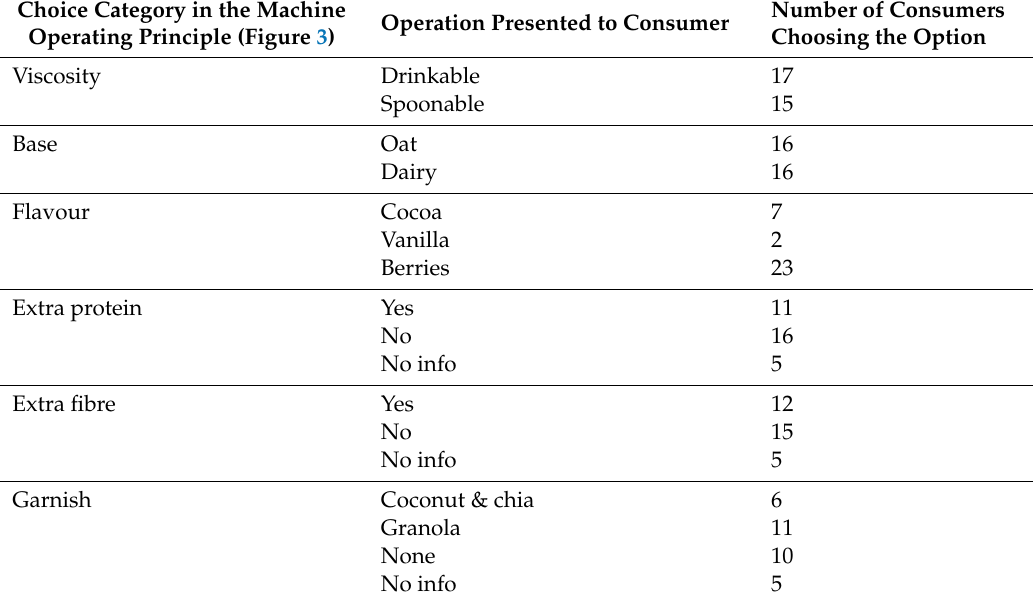
Table 4. Consumer choices ( N = 33) in the user interface during the qualitative study. “No info” indicates the five people who chose the quick choice, and thus, were not able to choose garnishes. Further, one person chose the quick choice and did not answer any questions on the